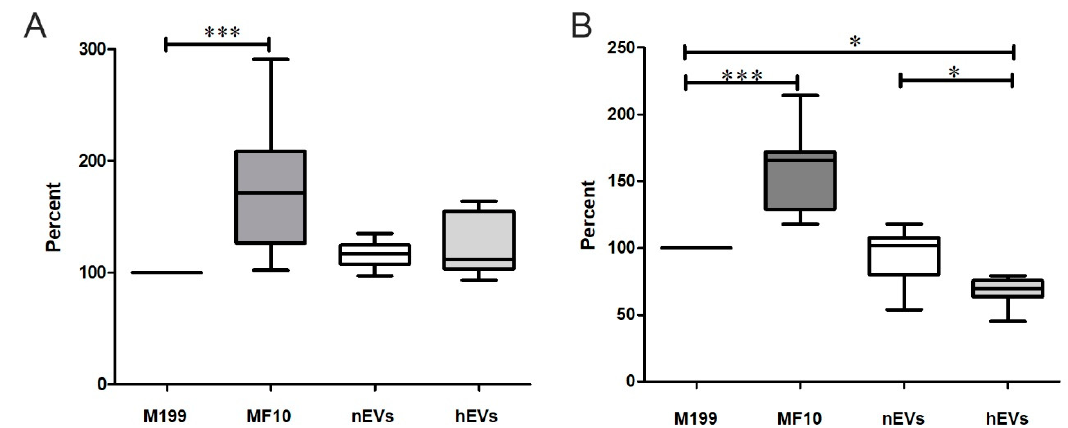
Figure 5. Effect of nEVs and hEVs on cultured TECs. ( A ) Cell viability after treatment with EVs. TECs were cultured with serum-free medium (M199), standard cell culture medium containing 10% fetal bovine serum (FBS) (MF10), or M199 containing nEVs or hEVs (3 × 10 8 EVs/well, correlating to an estimated 80,000 EV-releasing ASCs) for 48 h. The 2,3-bis-(2-methoxy-4-nitro-5-sulfophenyl)-2 H -tetrazolium-5-carboxanilide (XTT) assay was performed, and optical density was measured in a microplate reader at 492 vs. 650 nm (arbitrary units). Results were calculated as percent versus serum-free M199 as a control (=100%) (mean ± SD, n = 12–16). ( B ) Measurement of oxidative stress using 2 ′ ,7 ′ -dichlorofluorescein diacetate (DCF-DA). TECs were cultured with serum-free medium (M199), standard cell culture medium containing 10% FBS (MF10), or M199 containing nEVs or hEVs (3 × 10 8 EVs/well, correlating to an estimated 80,000 EV-releasing ASCs) for 48 h. Then, DCF-DA was added for 30 min at 37 °C. Fluorescence of intracellular DCF was measured and normalized to serum-free M199 (=100%; mean ± SD, n = 7–8). *** p < 0.001, * p < 0.05.